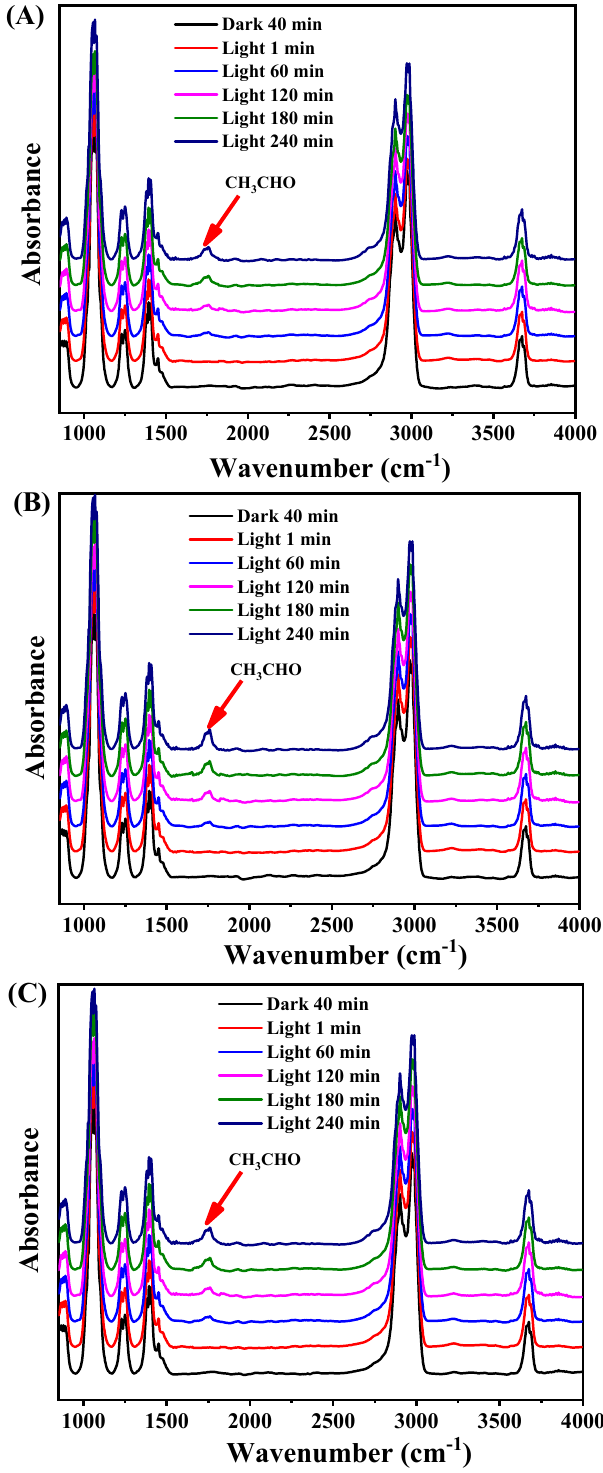
Figure 7. In situ FTIR spectra of ethanol adsorption on the catalysts during the photoreforming: ( A ) Au@Cu 2 O/TiO 2 , ( B )Au@TiO 2 /Cu 2 O, ( C ) Au@TiO 2 /Cu 2 O@Au.